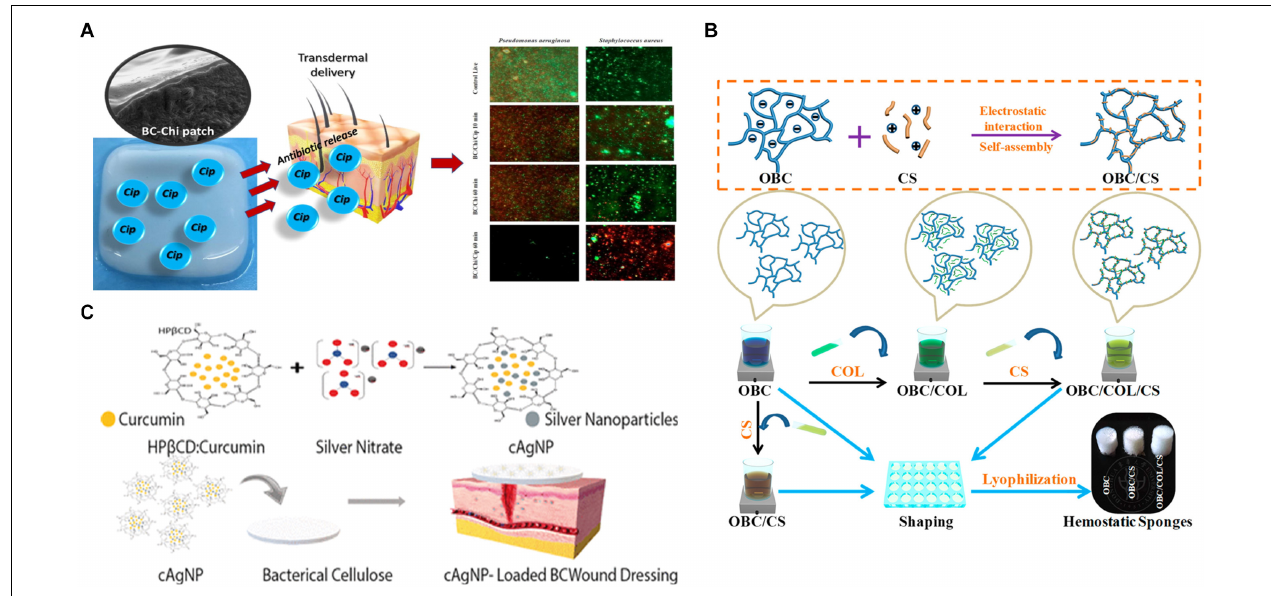
FIGURE 7 | (A) BC-Chi-CIP membrane for CIP controlled release with synergistic antibacterial effect of Chi and CIP (Cacicedo et al., 2020). (B) The preparation scheme of OBC/COL/CS hemostatic sponge with CS as antibacterial agent (Yuan et al., 2020). (C) Schematic representation of the preparation of cAgNP loaded BC-based wound dressing with synergistic antibacterial effect of curcumin and Ag NPs (Gupta et al., 2020).